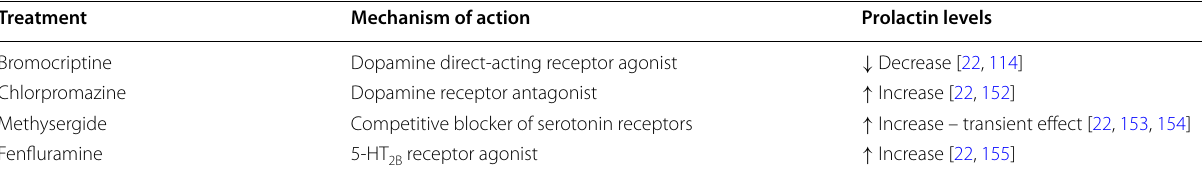
Table 2 Treatments that can modify levels of prolactin